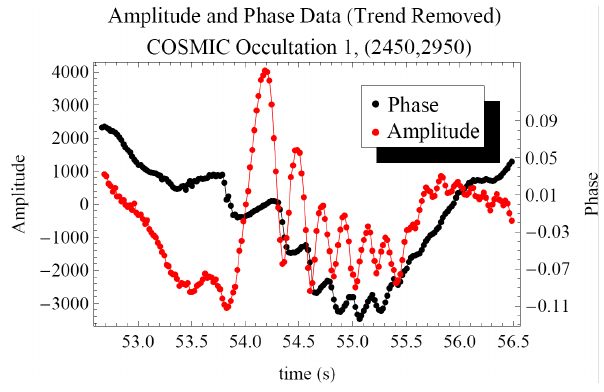
Fig. 26. SNR data for COSMIC occultation number 1 (black). Trend curve is in red and the vertical, dashed blue lines indicate the analysis window.